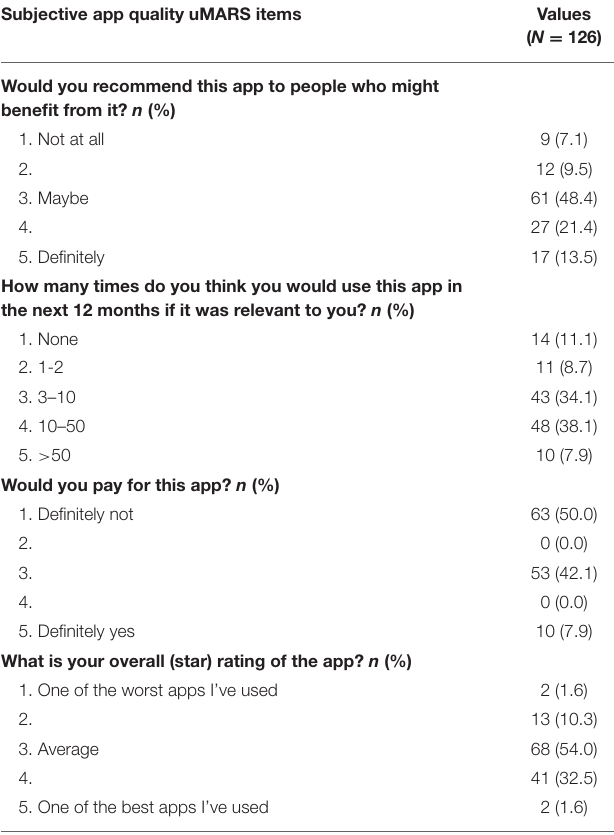
TABLE 3 | Subjective app quality uMARS item ratings. Subjective app quality uMARS